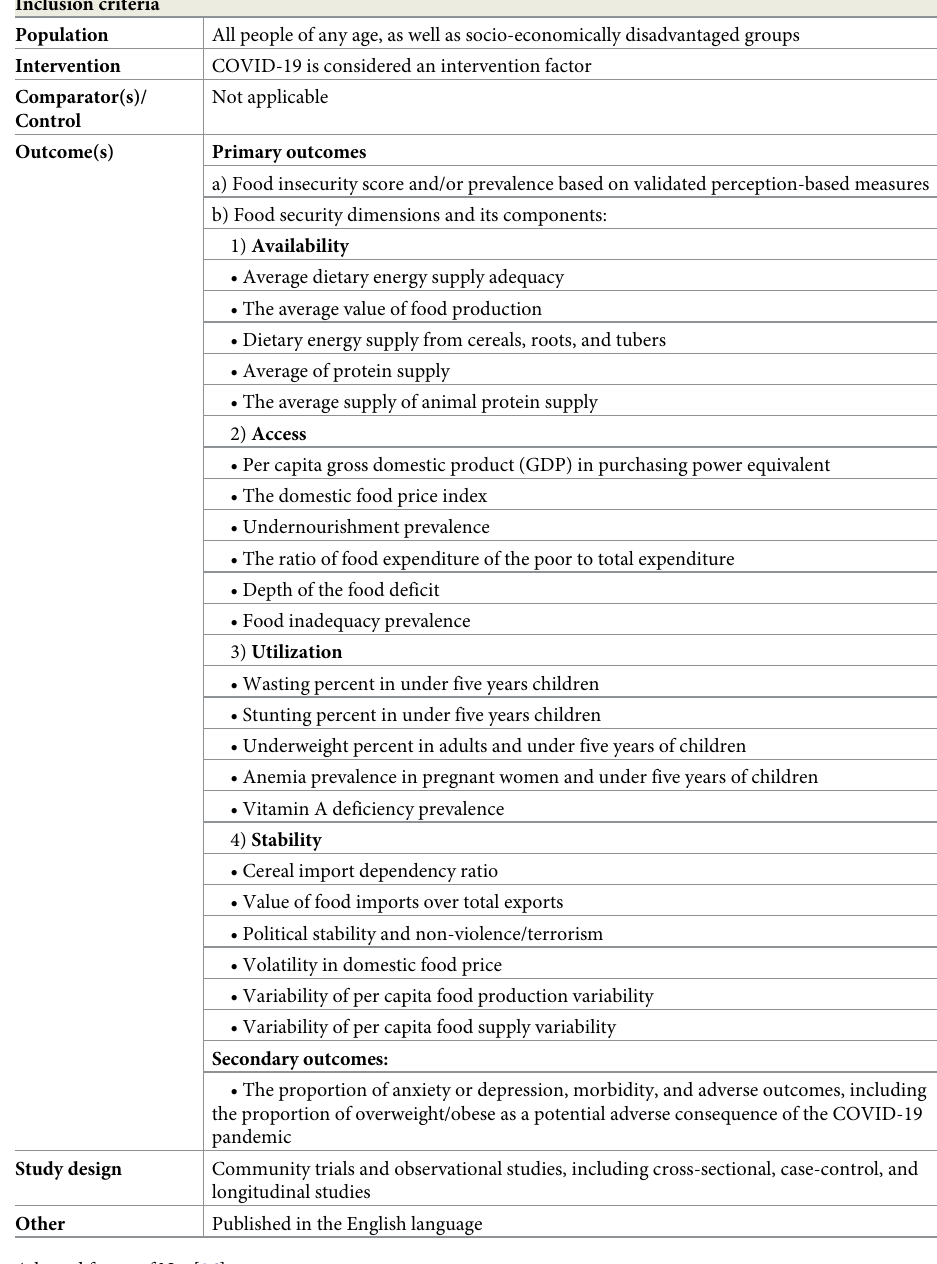
Table 1. Study inclusion criteria based on PICO elements